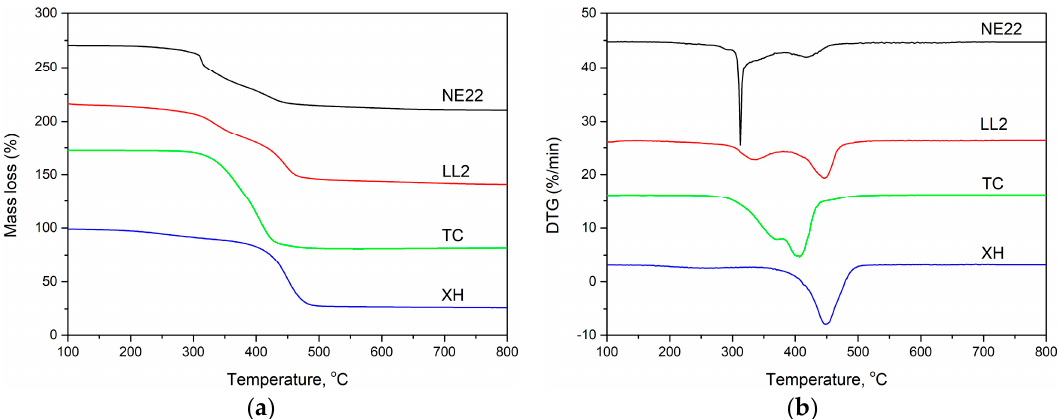
Figure 9. Thermogravimetric (TG) ( a ) and DTG ( b ) curves at a heating rate of 10 °C/min under nitrogen for the four kind of belts. Table 6. The temperature of 5, 10 and 50 % weight loss, max. degradation rate and the fraction of the solid residue at 800 °C for belts.